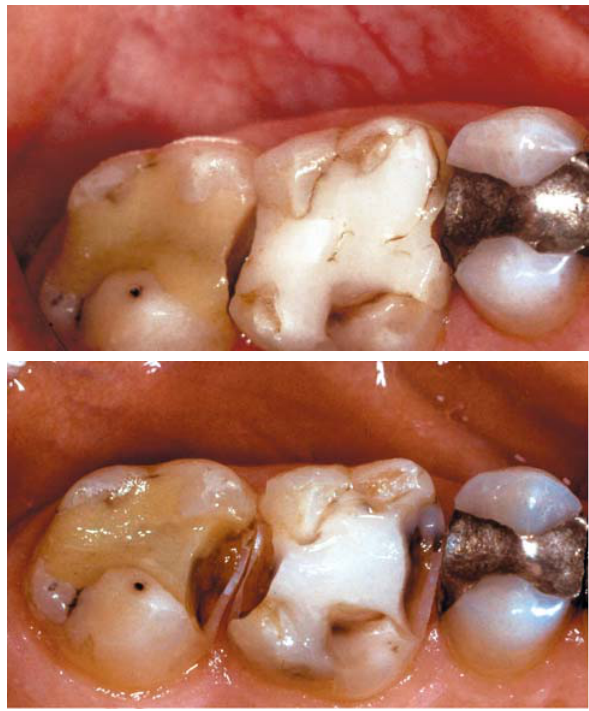
FIGURE 4- Dye infiltration in normally (a) and ultra-sonically (b) set GIC after 3 days water storage. (Courtesy Dr. Raimond van